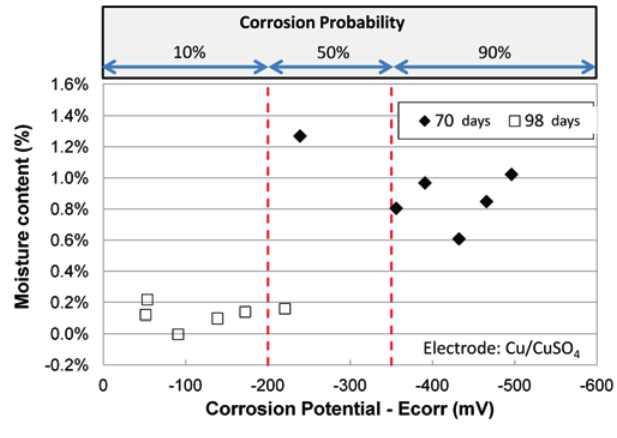
Figure 4 Correlation between corrosion potential and moisture